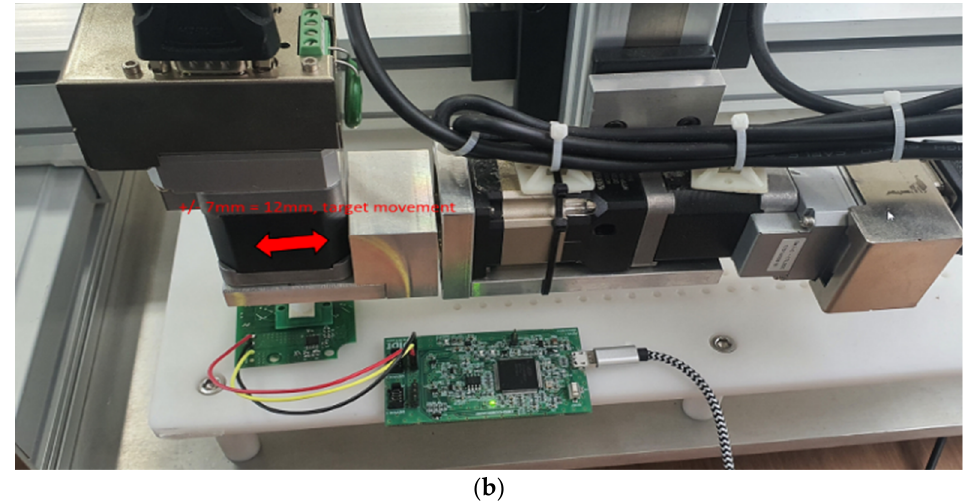
Figure 10. Test setup for long-stroke inductive position sensor (IPS). ( a ) PCB shape with vehicle sensor and target (yellow) shape. ( b ) Actual test equipment and IPS PCB layout.